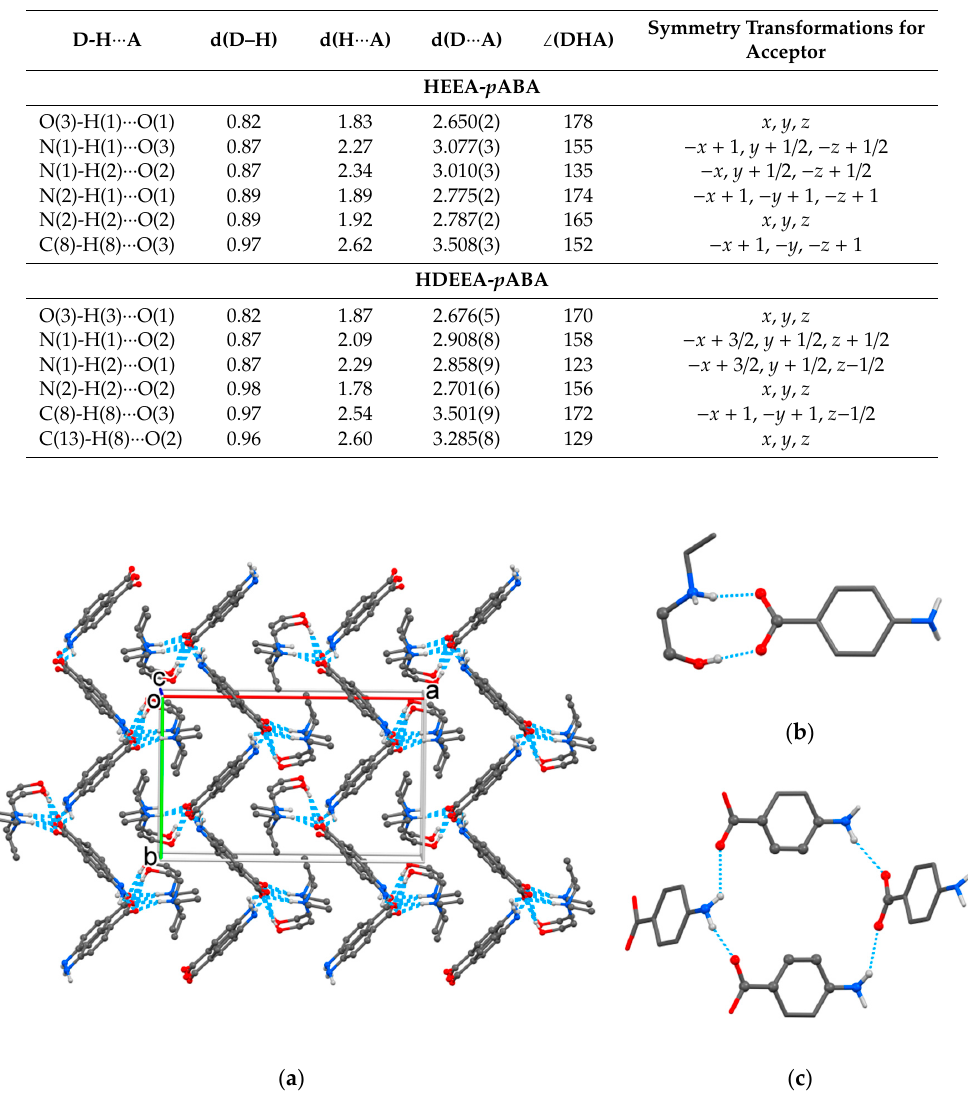
Table 2. Hydrogen bond distances (Å) and angles ( ◦ ) in HEEA- p ABA and HDEEA- p ABA.